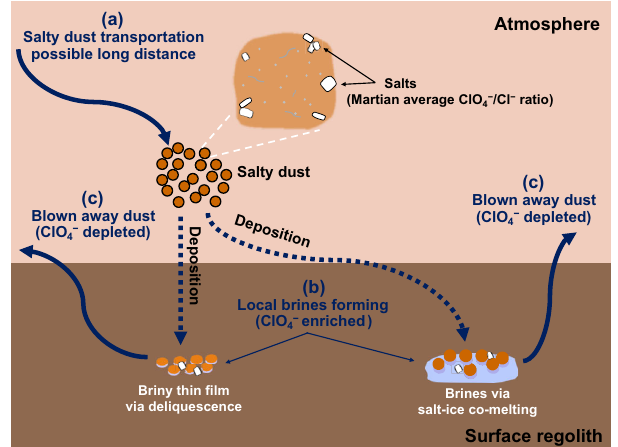
Fig. 5 A conceptual model for forming and preserving high perchlorate/ chloride ratios on the present Martian surface by coupling briny-aeolian process. a Aeolian processes (e.g., dust storms/dust devils) continuously transfer dust/soil particles coated with perchlorate-chloride salt mixtures (ClO 4 − /Cl total ratios presumably at the global-average) in some regions (e.g., the Mars arctic region). b Under appropriate RH- T conditions, the deliquescence of the perchlorate-chloride salt mixture by interaction with water-vapor or water-ice can produce transient brines containing fractionated ClO 4 − /Cl − signatures. The speci fi c ratios depend on the parent salts and the RH- T conditions. c Dust/soil particles cemented with brines would resist aeolian translocation better than dry ClO 4 − -depleted dust/soil particles. In this way, perchlorates preferentially accumulate in place while chlorides are more likely to be transported